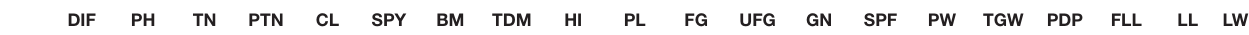
TABLE 2 | Correlation coefficients among yield-related traits of F 2 , F 3 , and F 4 population of 166s ×